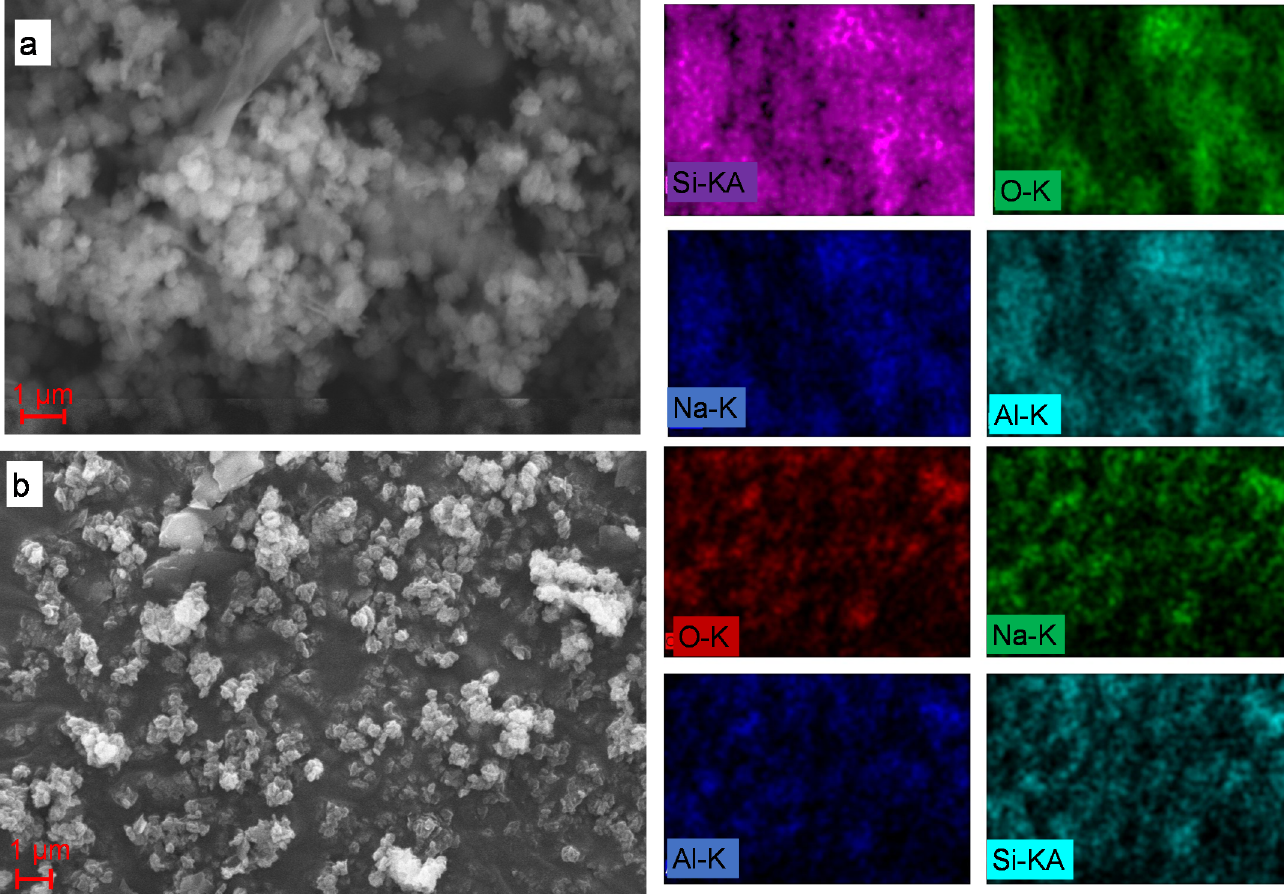
Figure 6. SEM analysis and elemental mapping on ( a ) SOD and ( b ) S80H9. Table 5. Elemental composition of